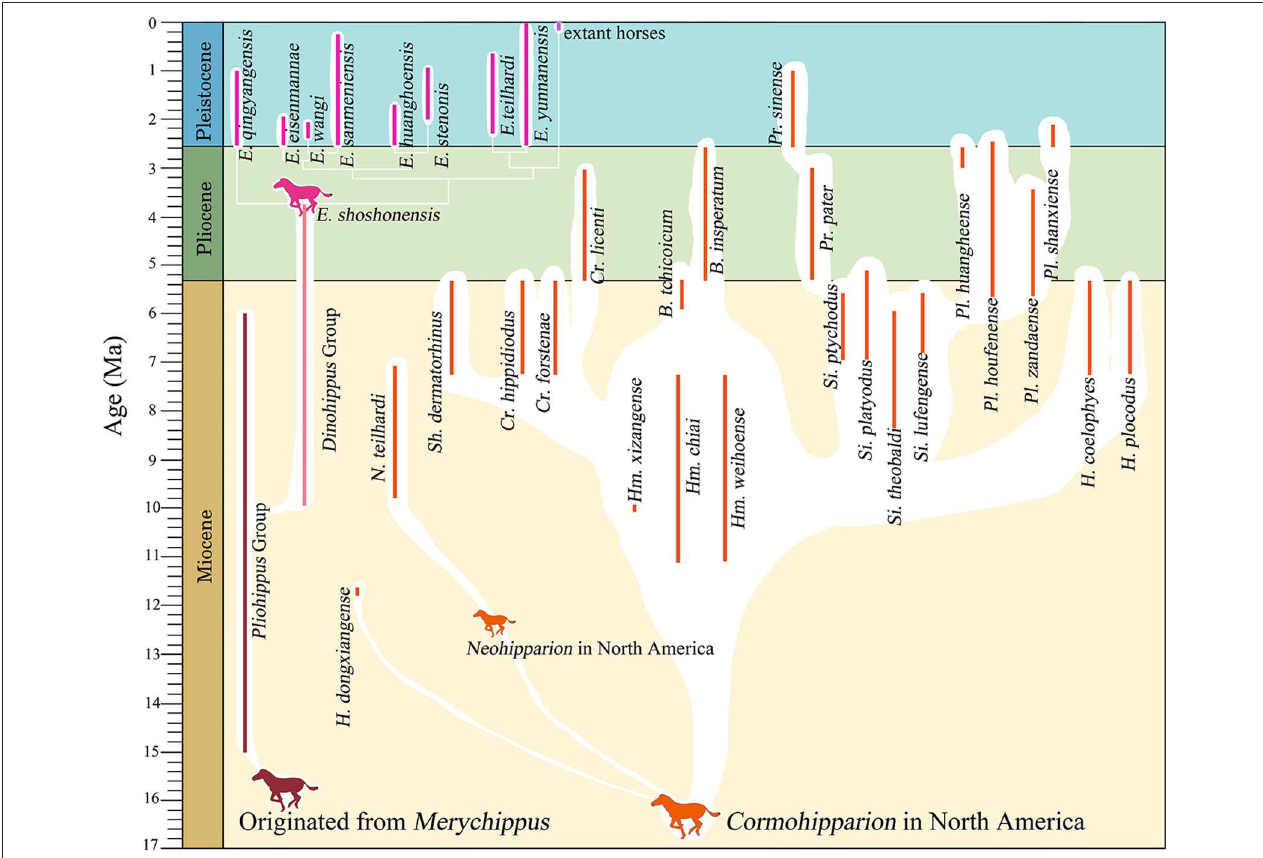
FIGURE 13 | Proposed phylogenetic interrelationships of species of hipparionine and genus Equus in China, based on Qiu et al. (1987), Li and Li (1990), Deng and Xue (1999a), MacFadden (2005), Sun (2013), Wolf et al. (2013), Deng et al. (2016), Bernor et al. (2018), and Sun et al. (2018). Abbreviations of genera: H, Hipparion (a polyphyletic group including all the species with undefined attribution); N, Neohipparion ; Sh, Shanxihippus ; Cr, Cremohipparion ; Hm, Hippotherium ; B, Baryhipparion ; Pr, Proboscidipparion ; Si, Sivalhippus ; Pl, Pliohipparion ; E, Equus